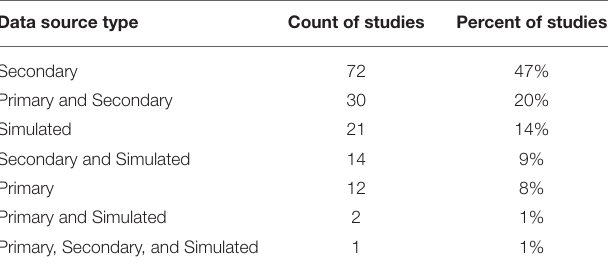
TABLE 4 | Data source type used for the primary studies.